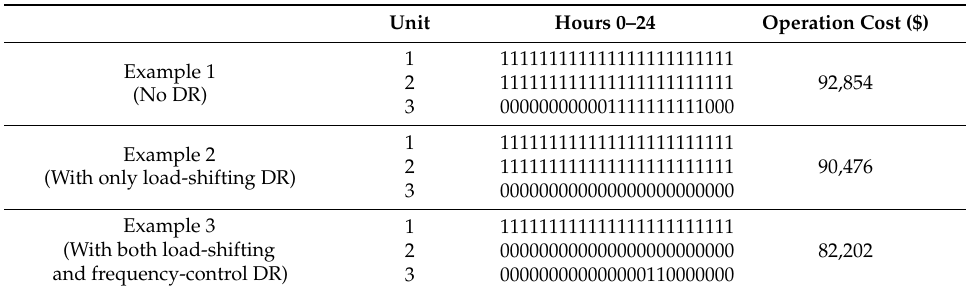
Figure 7. Calculation results of the three examples. ( a ) System loads; ( b ) Dispatched DR for the load-shifting; ( c ) Dispatched DR for the frequency control. Table 2. Unit commitment of the three examples of the six-bus system.